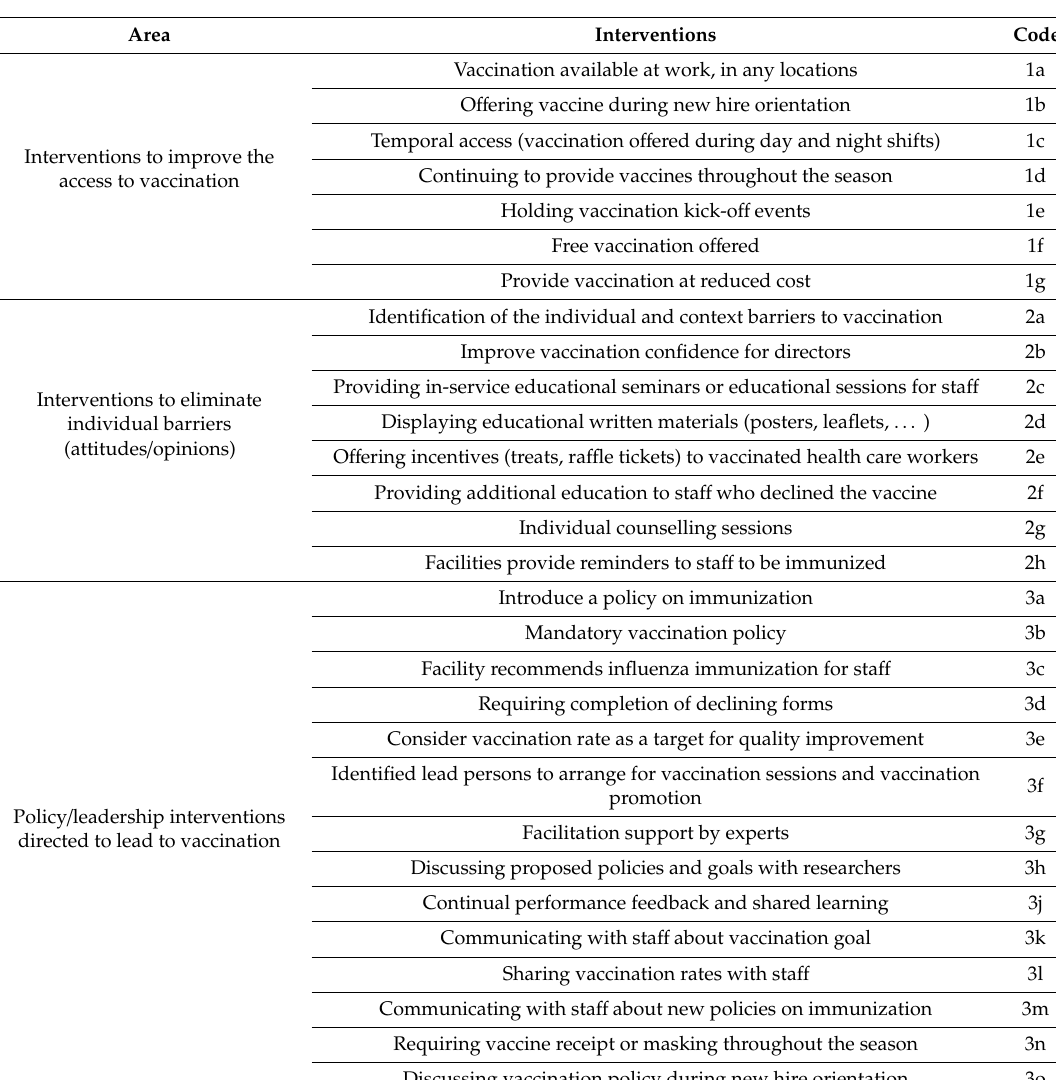
Table 1. Synthesis of the interventions performed in the studies, by area of